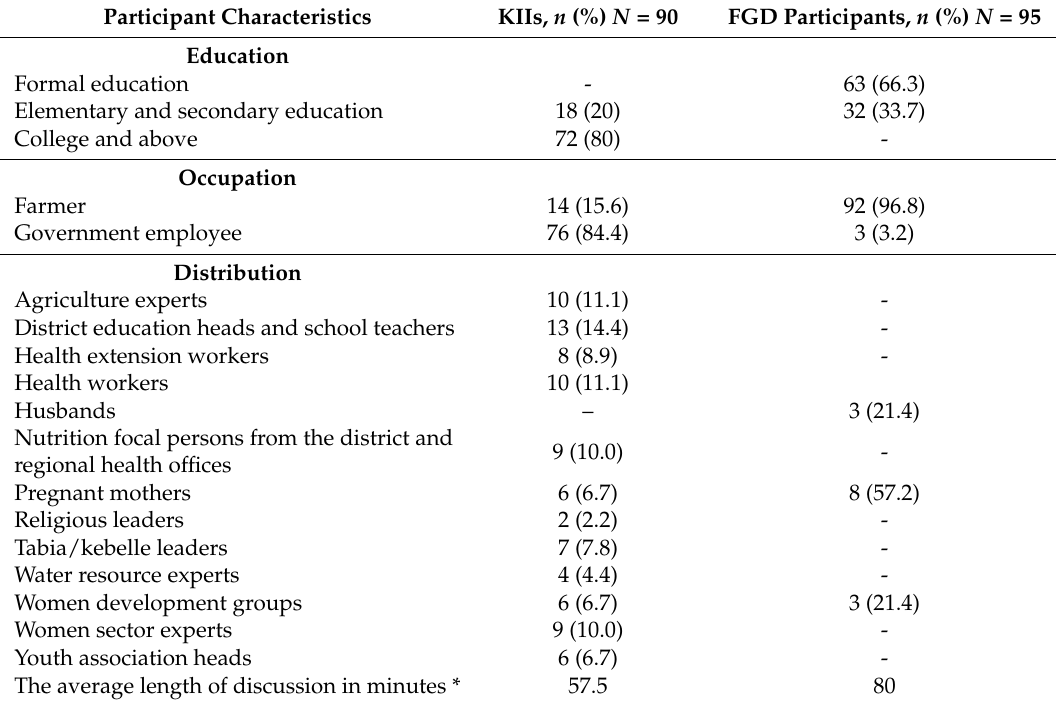
Table 1. Characteristics of the FGD and KII participants, Tigray, Northern Ethiopia,